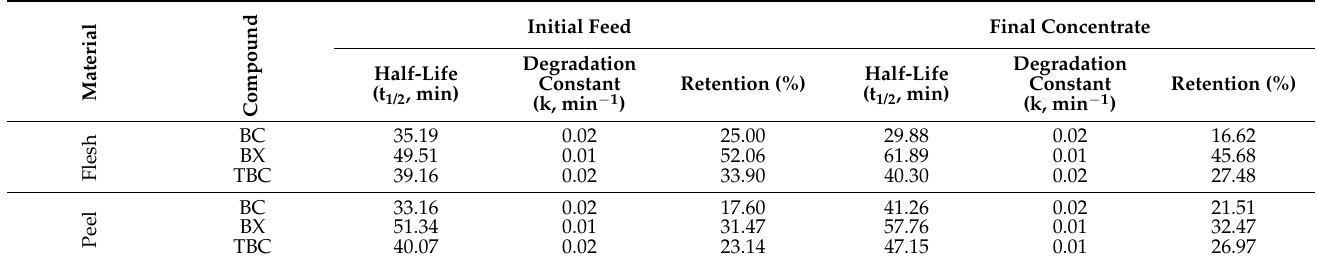
Table 6. t 1/2 , k, and retention of the betalains in beetroot flesh and peel concentrations after heating at 70 °C.